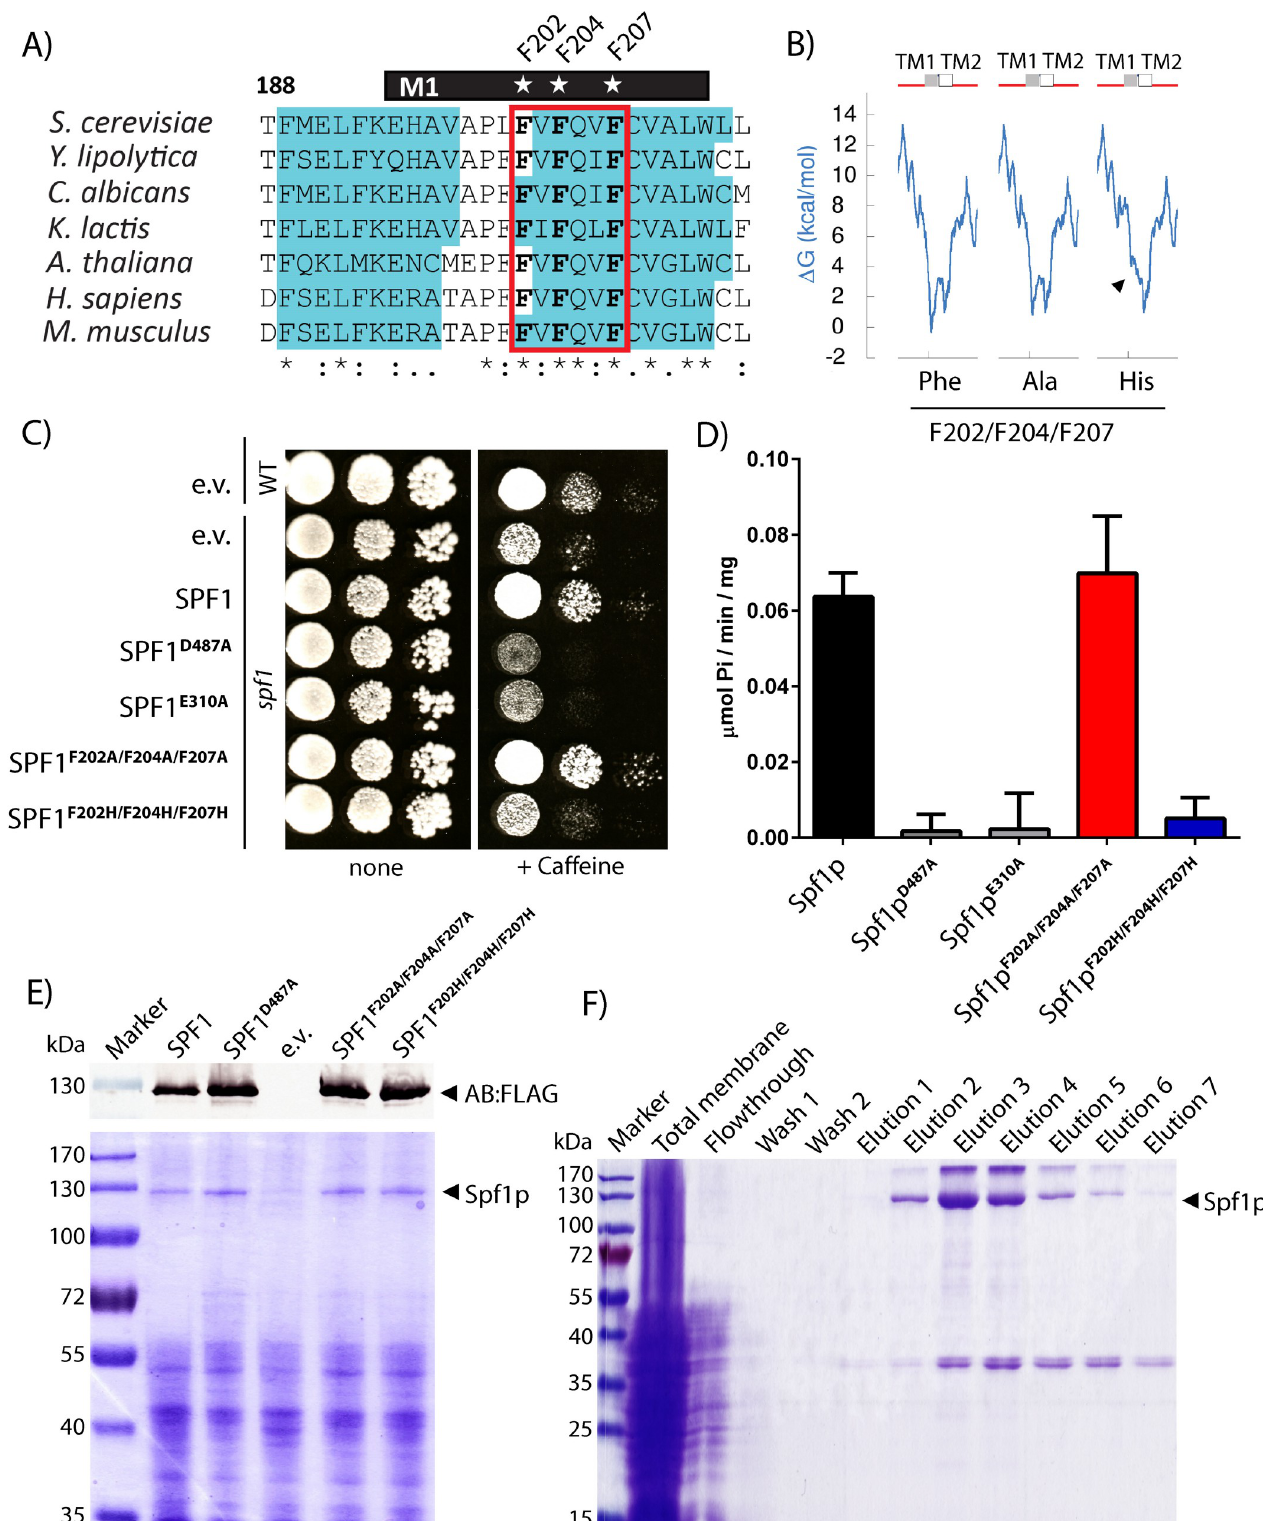
Fig 5. Viability of Spf1p and M1 mutated Spf1p. A) Alignment of M1 region of Spf1p and similar P5A ATPase sequences. Conserved residues F202, F204 and F207 indicated by star and predicted α -helical structure shown in blue. B) Calculated Δ G (kcal/mol) for folding of M1 and M2 in Spf1p and M1 mutated spf1p.